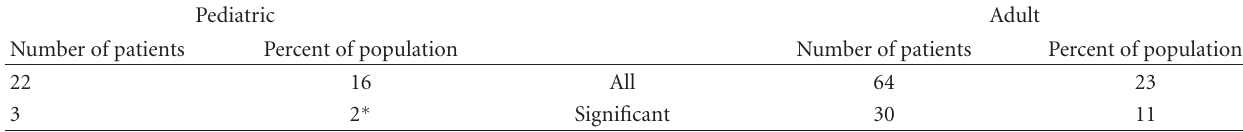
Table 2: Comparison of noncardiac findings in pediatric and adult